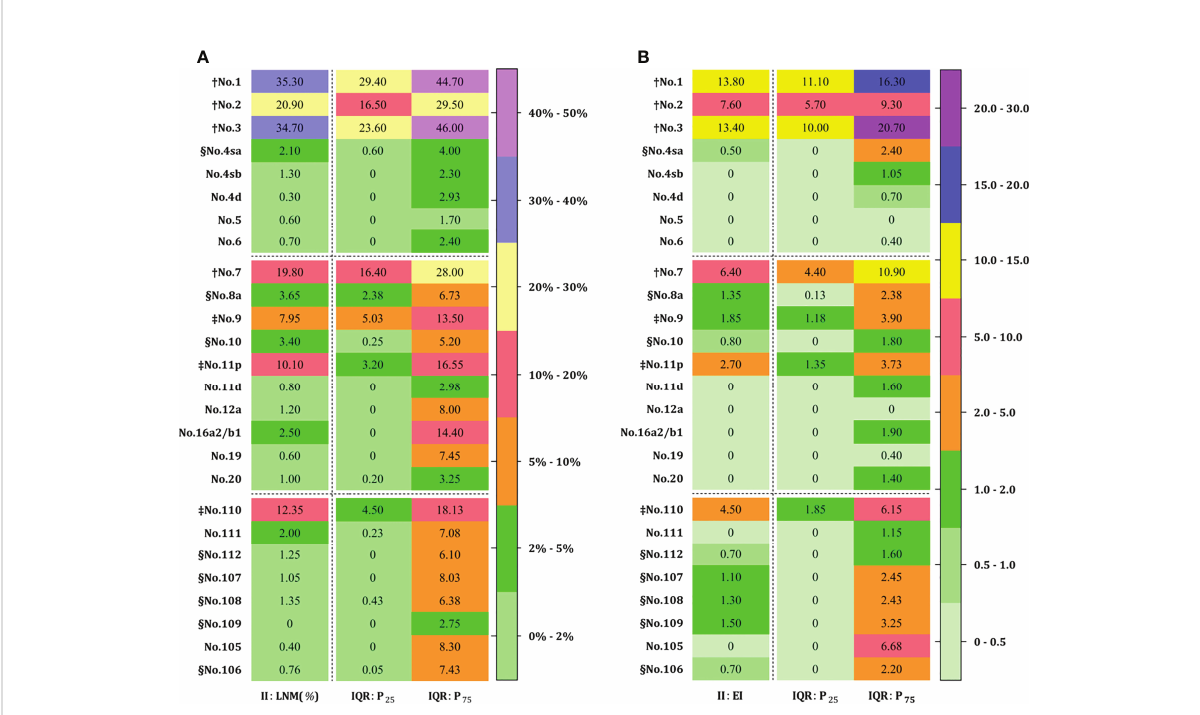
FIGURE 4 Lymph node metastasis (A) and ef fi ciency index (B) for advanced EGJ carcinomas at each station. † LNM-1 ≥ 10% EI-1 ≥ 5; ‡ LNM-2 ≥ 5% EI-2 ≥ 2; § LNM-3<5% EI-3 ≥ 0.5 (EI-3B ≥ 1.0 and EI-3B ≥ 0.5). LNM-1 and LNM-2 nodes with LNM ≥ 10% and 5% are designated as obligatory stations for dissection in any case (A) , and corresponding to EI-1 and EI-2 nodes with EI ≥ 5 and 2 (B) , while both EI-3A and EI-3B nodes with EI ≥ 1 and EI ≥ 0.5 are designated as optional stations. The obligatory stations for dissection is determined by the epicenter location, whereas the optional stations remain dependent on the tumor extension. The obligatory nodes are located at the no. 1, 2, 3, 7, 9, 11p, 110 stations, whereas optional nodes are located in abdominal no. 4sa~6, 8a, 10, 11d, 12a, and 16a2/b1 stations and mediastinal no. 105~112 stations. Accordingly, EI-1 and EI-2 nodes were consistent with those with a rate over 5%. In contrast, optional nodes with a rate of less than 5% were assigned to EI-4 less than 0.5% and EI-3 less than 2%, respectively. EGJ, esophagogastric junction; II, Siewert type II; LNM, lymph node metastasis; EI, ef fi ciency index; IQR, interquartile